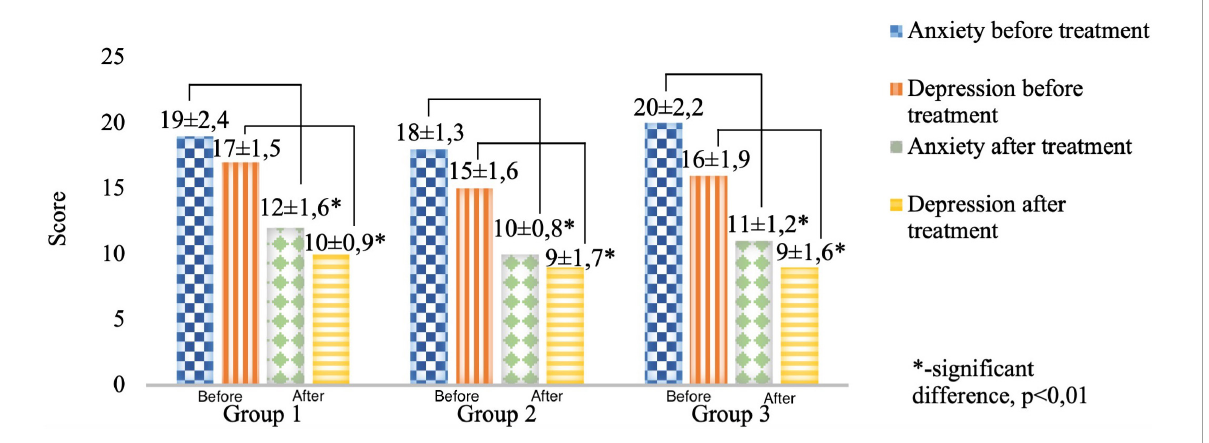
FIGURE5 Comparative characteristics of the results of the HADS clinical scale in the study groups before and after therapy (score).